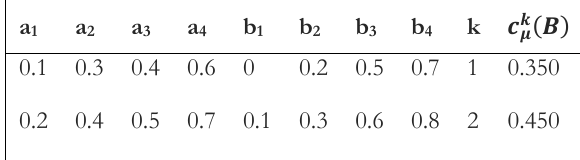
Table 2. Calculation of 𝐜 𝛍𝐤 (𝐁).